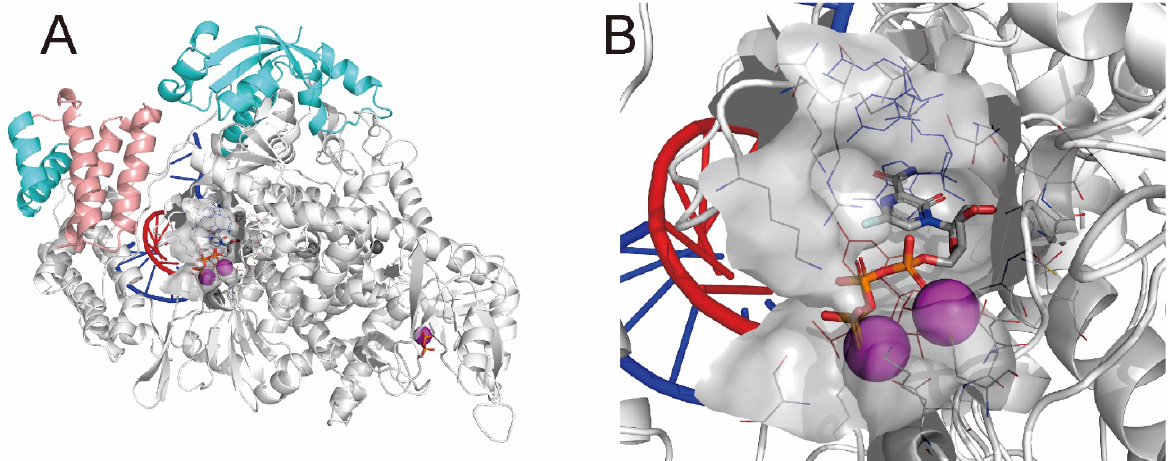
Figure 1. Refined cryo-EM structure (PDB ID: 7AAP) of the SARS-CoV-2 RdRp complex:dsRNA bound with favipiravir-RTP. ( A ) The whole structure and ( B ) the enlarged structure of the active site. RdRp (nsp12), two nsp8 subunits, and one nsp7 subunit are presented as white, cyan, and pink ribbons, respectively. Primer and template RNAs are presented as red and blue coils, respectively. Favipiravir-RTP is presented in CPK color using tubes. Pyrophosphate is presented using tubes. Magnesium and zinc ions are presented as magenta and dark gray spheres, respectively. Residues located 5 Å from the favipiravir-RTP are presented using lines without hydrogen atoms. The van der Waals surfaces of the active sites are presented in gray.